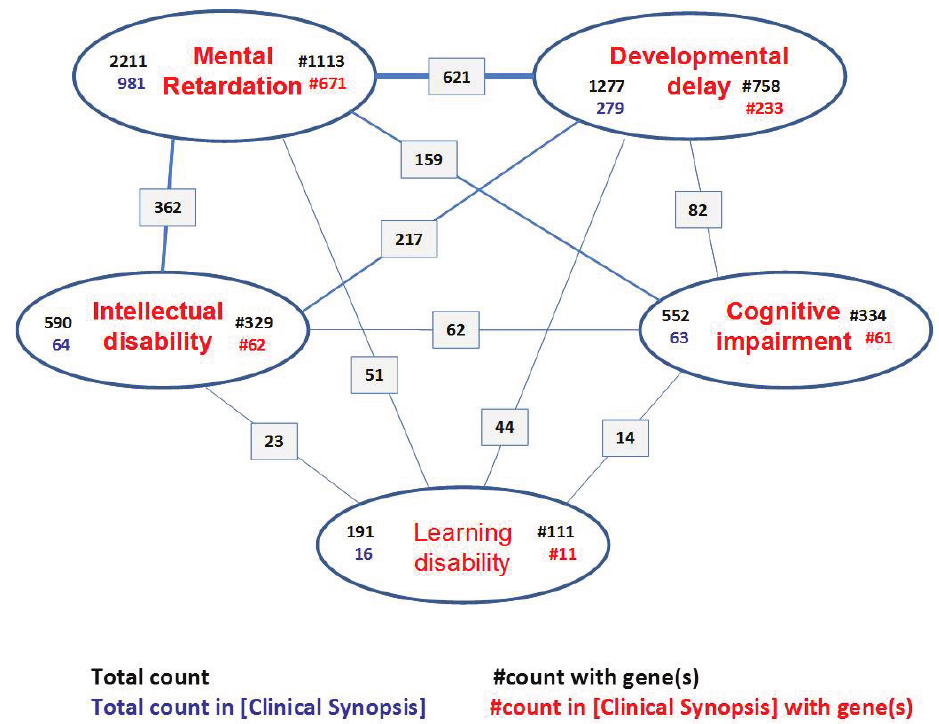
Figure 3. Counts of the major terms describing impaired development of cognitive functions in OMIM. The largest number indicated in black on the upper left of each term is the total number of counts without any limits, whereas the number of entries with the term specified in the Clinical Synopsis is indicated in blue on the lower left. To the right of each term are the counts of entries containing the term linked to at least one gene (upper right with a pound prefix [#], in black) and all entries containing the term in their Clinical Synopsis AND being linked to at least one gene (lower right with a pound prefix [#], in red). OMIM, Online Mendelian Inheritance in Man.